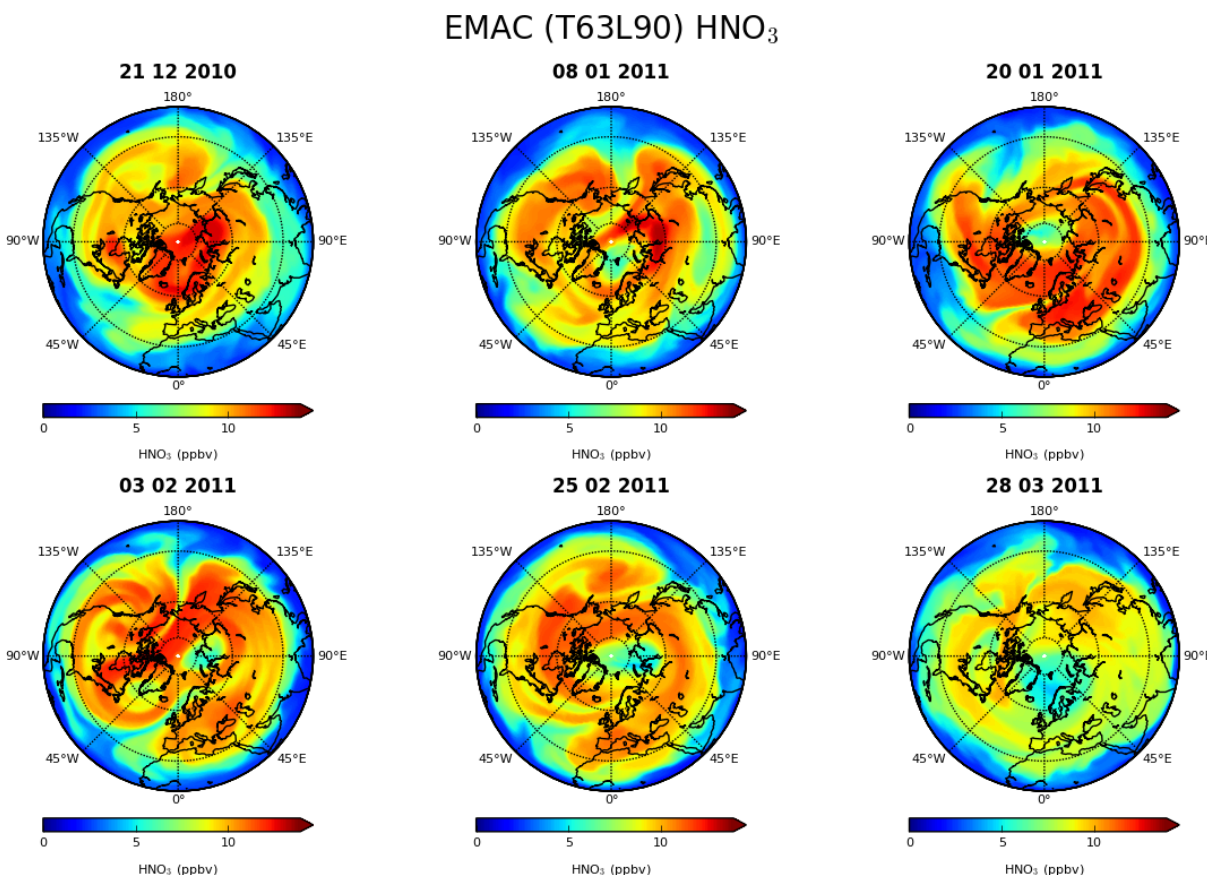
Figure 7. Distribution of HNO 3 as simulated with EMAC for 21 December 2010, 8 and 20 January 2011, 3 and 25 February 2011, and 28 March 2011 at 34hPa ( ≈